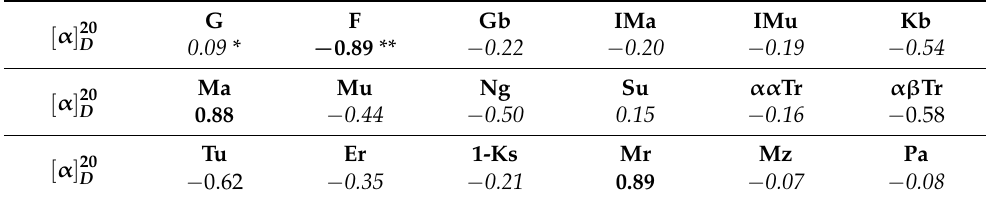
Figure 2. Magnitude of specific rotation angle for different honey types—diluted (dl), chestnut (ch), conifer (cf), oak (ok), thistle (ts), thyme (tm), coriander (cr), rapeseed (rs), polyfloral (pf), acacia (ac), linden (ld), mixed (mx), and pine cone jam (jm). Table 3. Pearson’s coefficient (r) determining the effect of individual saccharides on the optical angle of